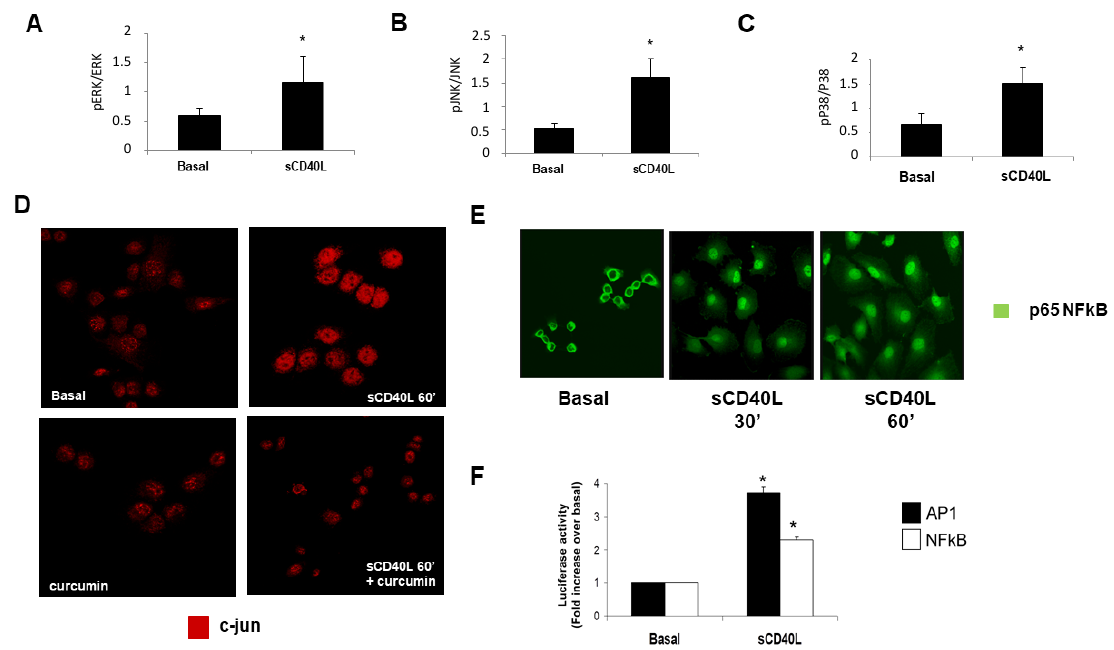
Figure 2. The effect of CD40 ligation on the activation of MAPK (ERK, JNK, P38) and of nuclear transcription factors (AP-1 and NFkB) in RCC cell lines. ( A – C ) Quiescent RCC cell lines were stimulated with sCD40L (100 ng/mL) and sCD40L enhancer (1 µ g/mL) for 60 min and then lysed in RIPA buffer. Equal amounts of protein from each cell lysate (40 µ g) were separated by SDS PAGE, transferred onto nitrocellulose membrane, and then analyzed by western blotting for the expression of p-ERK1/2, p-JNK or p-P38 normalized to ERK1/2, JNK1 or P38 respectively. The figure is representative of three experiments. * p < 0.005 vs. basal. ( D ) Jun activation in RCC cell lines in the presence or absence of curcumin, a specific JNK-AP1 inhibitor, was analyzed by confocal microscopy. The figure is representative of three experiments on different RCC cell lines. Cells magnification 60X. ( E ) NF κ B activation was analyzed by confocal microscopy using an antibody recognizing the p65 subunit of the nuclear factor. RCC cells were stimulated with sCD40L (100 ng/mL) and sCD40L enhancer (1 µ g/mL) or sCD40L enhancer alone in the basal condition, for 30 and 60 min respectively and then processed as described in methods. The figure is representative of three experiments. Cells magnification 60 × . ( F ) Confluent, quiescent RCC cells were trypsinized and 5 × 10 6 cells were resuspended in half milliliter medium containing 7.5 µ g of pLucNF-kB vector and 2.5 µ g of pCMV β Gal. Electroporation was carried out as described in methods. In separate sets of experiments quiescent 5 × 10 6 RCC cells were resuspended in half milliliter medium and 0.4 µ g of pLuc3XAP1 were added. Luciferase activity was measured as described in methods. The figure is representative of three experiments. * p < 0.01 vs.